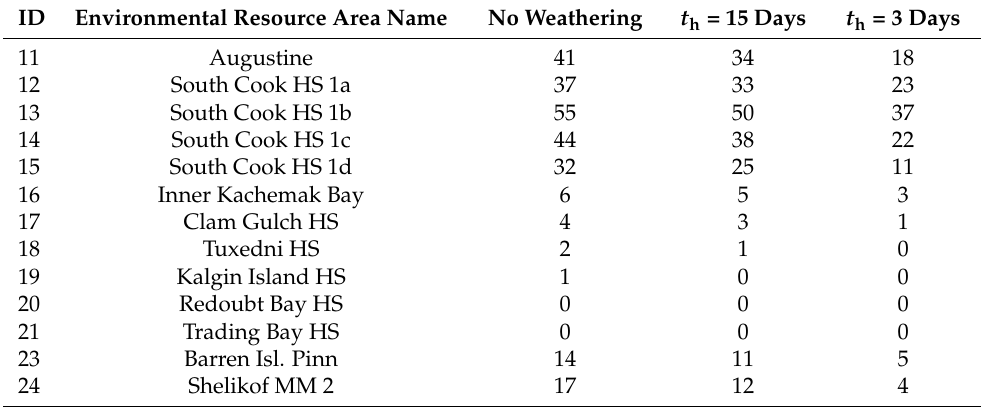
Table 1. The effect of weathering on annual conditional probabilities (expressed as percent- age